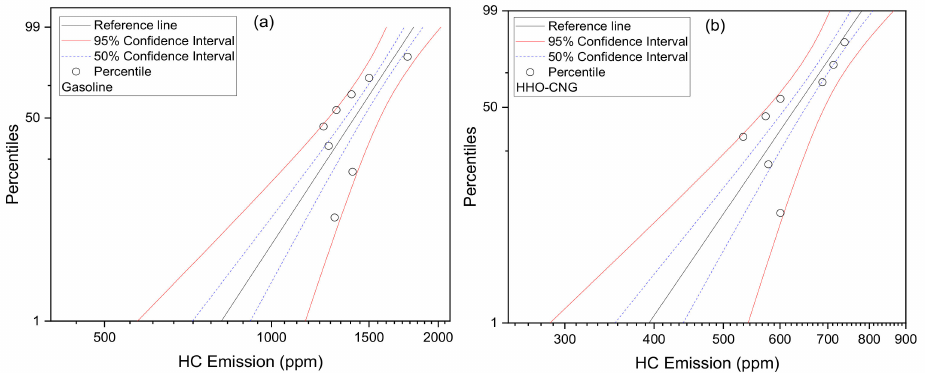
Figure 3. ( a ) HC Weibull distributions for various CIs using gasoline and ( b ) HC Weibull distributions for various CIs using HHO–CNG.